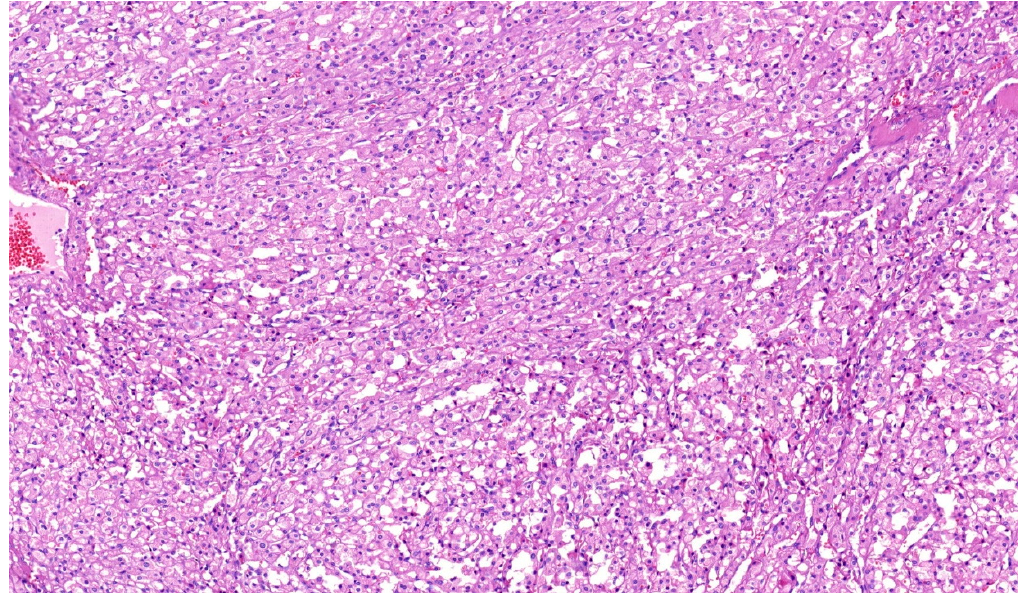
Figure 2. SDHB-deficient RCC with typical morphology-eosinophilic renal tumor with numerous vacuoles resembling texture of bubble wrap. 10× magnification.